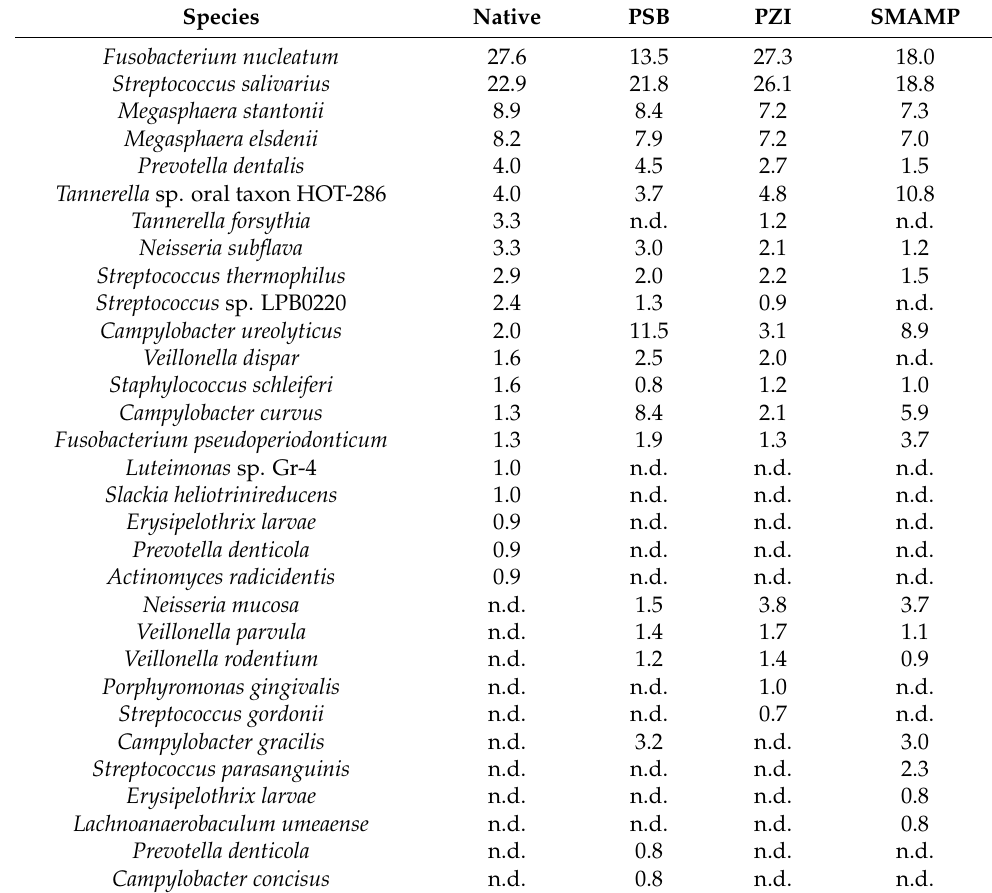
Table 2. Relative abundance of bacteria (in percent), found in the native biofilm, and the biofilms formed on PSB -, PZI -, and SMAMP -coated substrates, listed by species. Standard deviations of the data are found in Tables S2–S5 in the Supporting